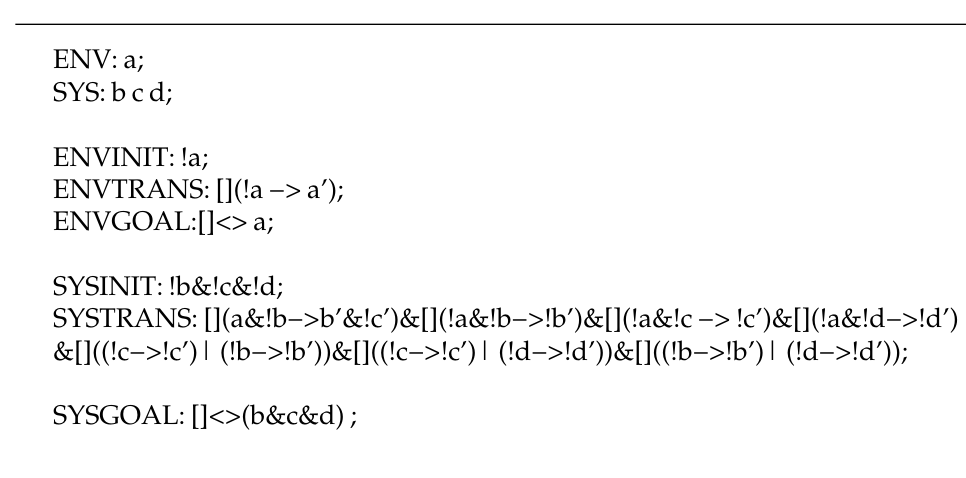
Figure 1. Example showing motion planning under stochastic environment